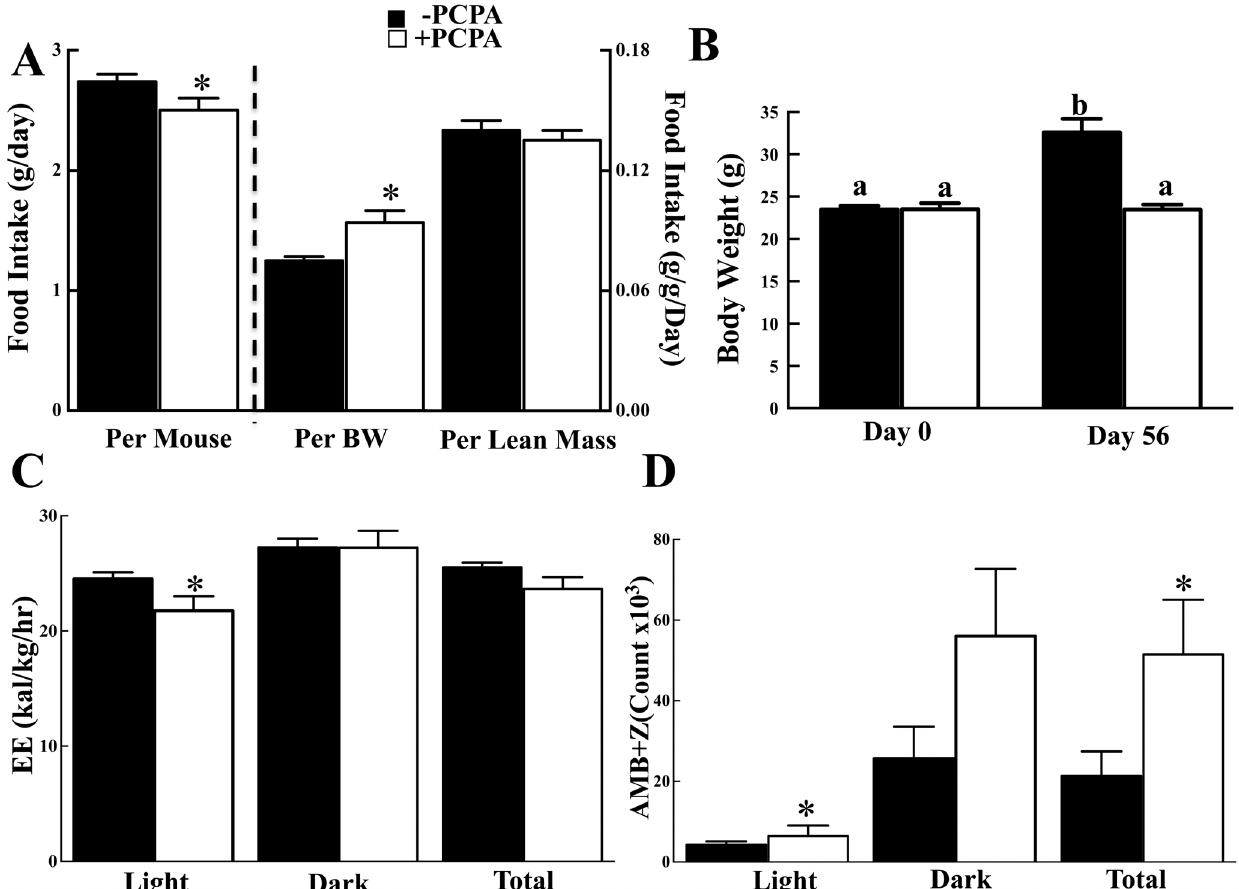
Figure 5. PCPA treatment has no effect on caloric intake but increases locomotor activity. Mice were fed HFD for 7 weeks and injected PCPA intraperitoneally every other day for a total of three times during the last week. (A) Food intake was normalized per mouse, per body weight and per lean mass. (B) Body weights and fat masses of HFD-fed mice were measured immediately prior to PCPA injection and two days after the third injection. Indirect Calorimetry was carried out immediately after the third injection. (C) Average energy expenditure during the 12-hour light cycle from 7 am to 7 pm and the 12-hour dark cycle from 7 pm to 7 am. (D) The sum of ambulatory and vertical movements. Mice were fed a HFD with or without 2-PCPA for 21 days and fed ad libitium. The mice were then restricted to 70% of their individual food intake for 17 days. (C) Body weight. (D) Fat mass. (E) Lean mass. n=5 in each group. In panels (A) and (B) the bars represent means 6 standard errors. (*) indicates a statistically significant difference (p , 0.05) between the start (day 0) and end (day 17) of caloric restriction. In panels (C) and (D) statistical analysis was performed using a two-way ANOVA followed by the Student-Newman-Keuls multiple range test. Identical letters indicate data points that are not statistically different from each other (p ,